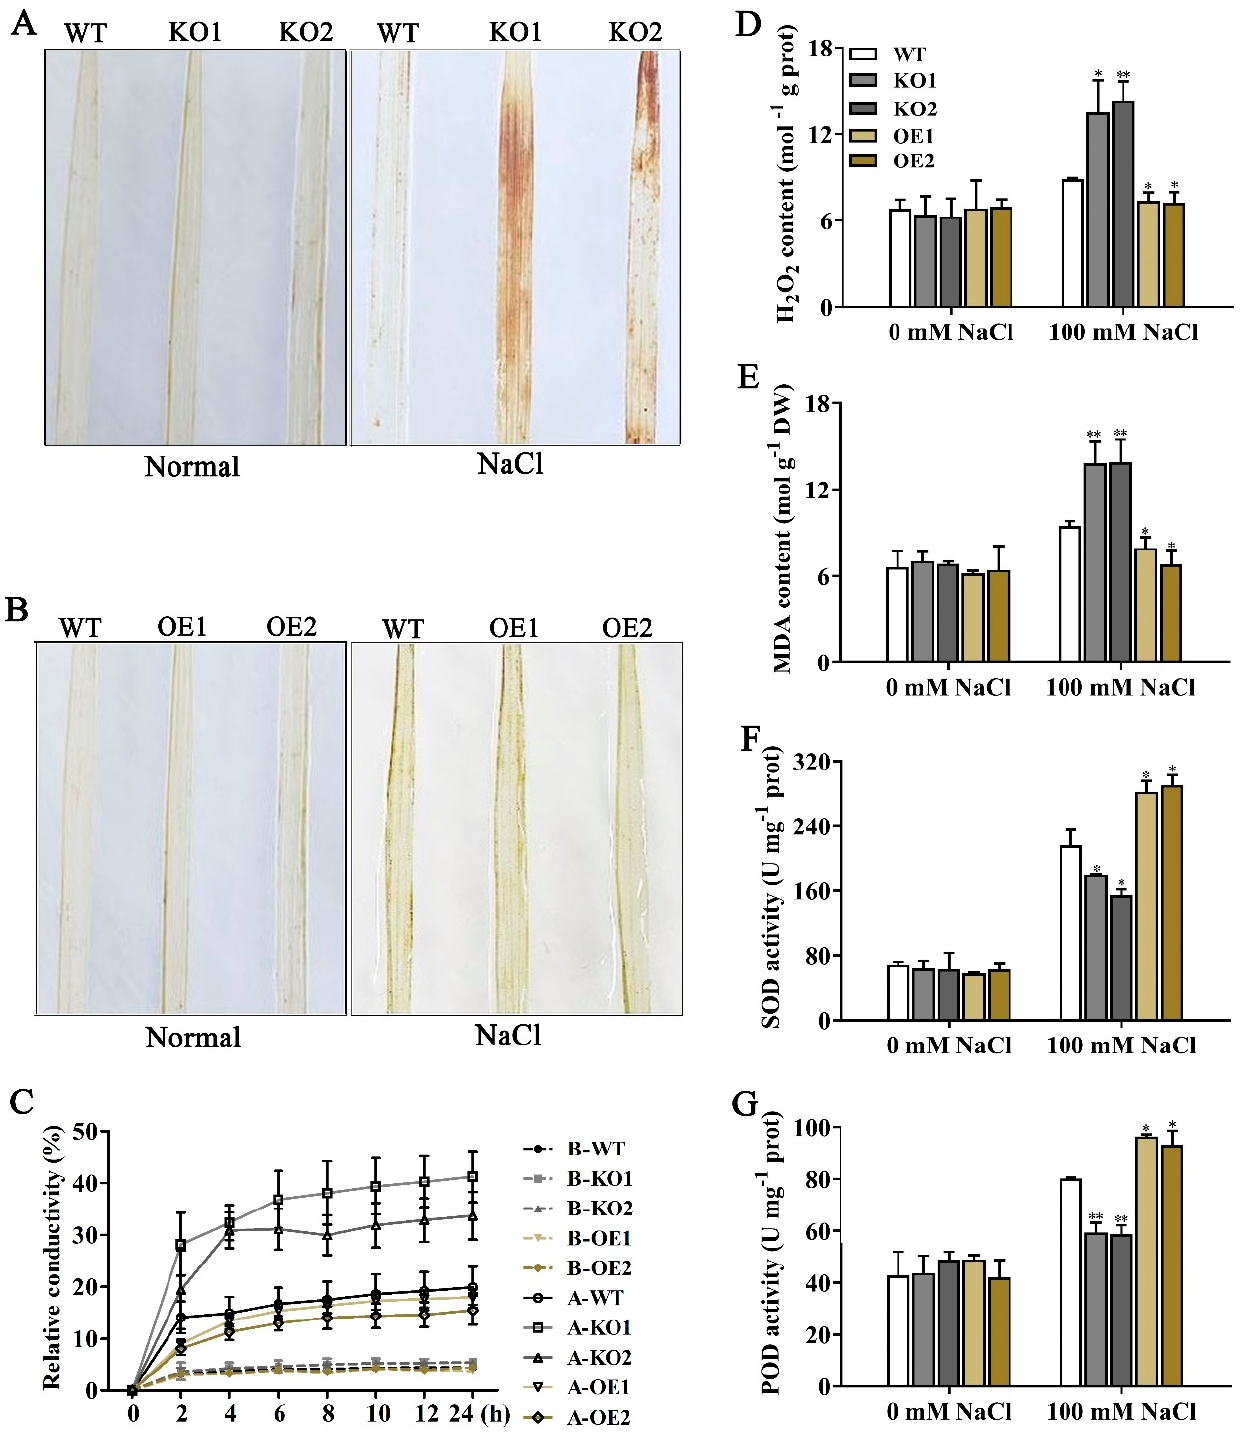
Figure 6. OsJRL40 increased the antioxidant capacity of rice under salt stress. ( A , B ) DAB staining of the leaves of WT, KO, and OE seedlings exposed to salt stress for 2 d. ( C ) Percent electrolyte leakage. ( D ) H 2 O 2 content. ( E ) Malondialdehyde (MDA) content. ( F ) Superoxide dismutase (SOD) activity. ( G ) Peroxidase (POD) activity. In ( C – G ), 15-day-old seedlings were treated with 100 mM NaCl for 2 d prior to the sampling of leaves. Data represent the mean ± SD of three independent replicates. Asterisks indicate statistically significant differences (Student’s t -test; * p < 0.05, ** p < 0.01).